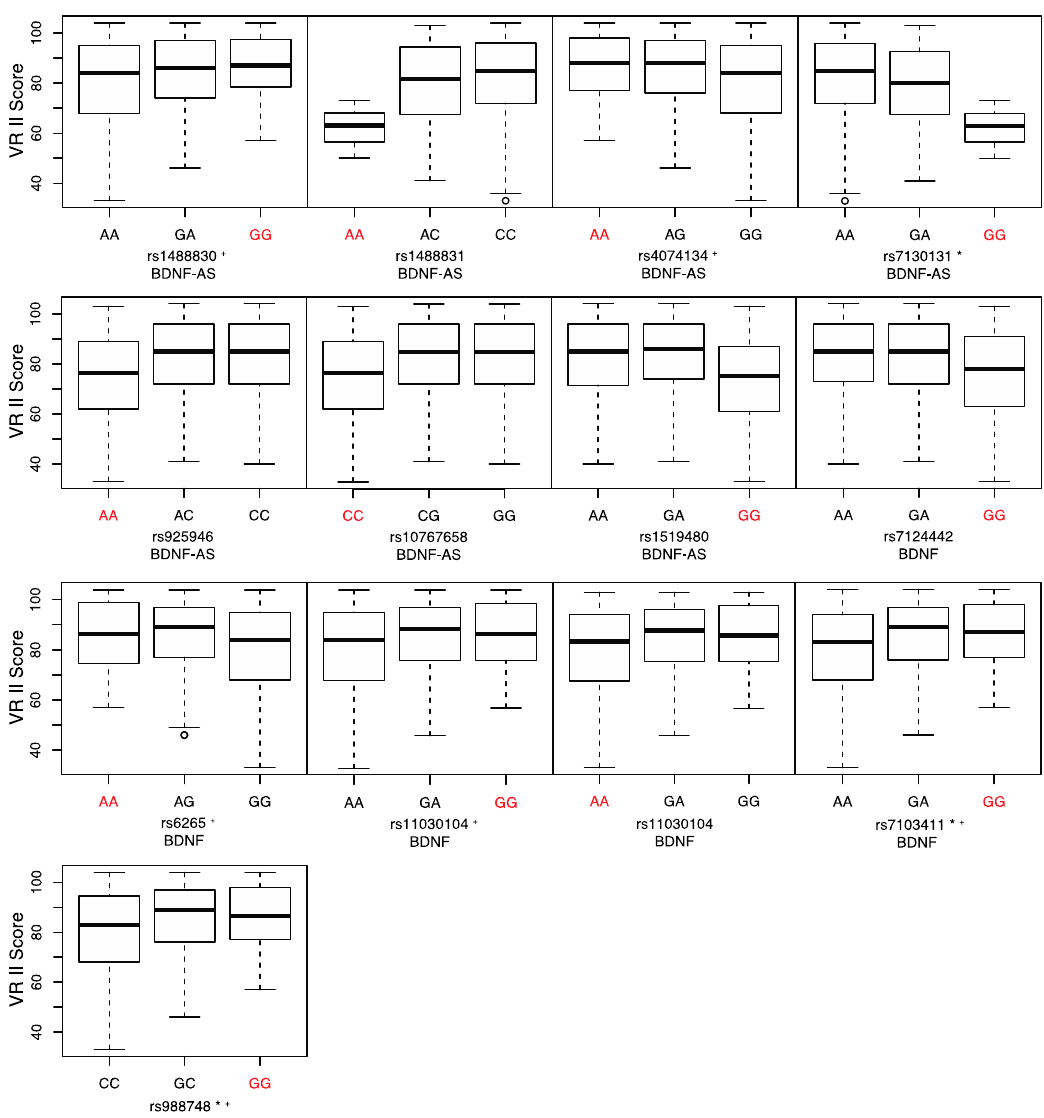
Figure 2. Visual Reproduction II (VR II) scores and allelic distribution of significant SNPs. Boxplots showing genotypes of the significant SNPs in BDNF and BDNF-AS genes with long-term visual memory scores. VR II was used to measure long-term visual memory. * SNPs significantly associated with VR II. + SNPs with a positive beta score. The minor alleles of the SNPs are shown in red.